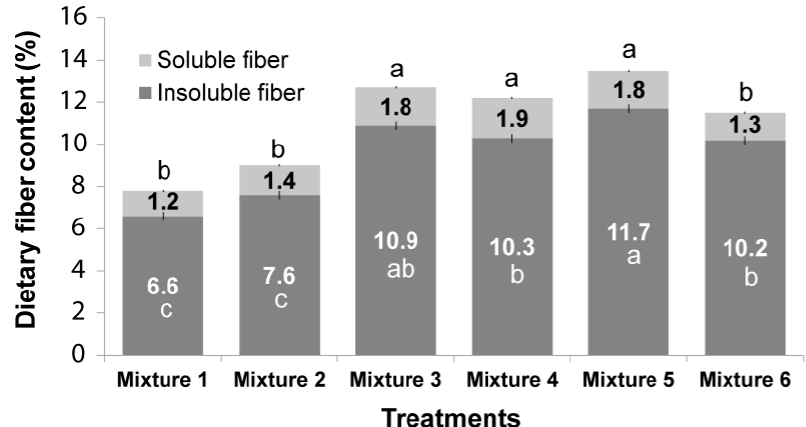
Figure 1. Insoluble and soluble dietary fiber content of extruded products. Means ± standard error (SE). SE insoluble fiber, 0.2; SE soluble fiber, 0.05. Means by columns and colors with different letters show significant differences based on contrast tests ( p < 0.05).